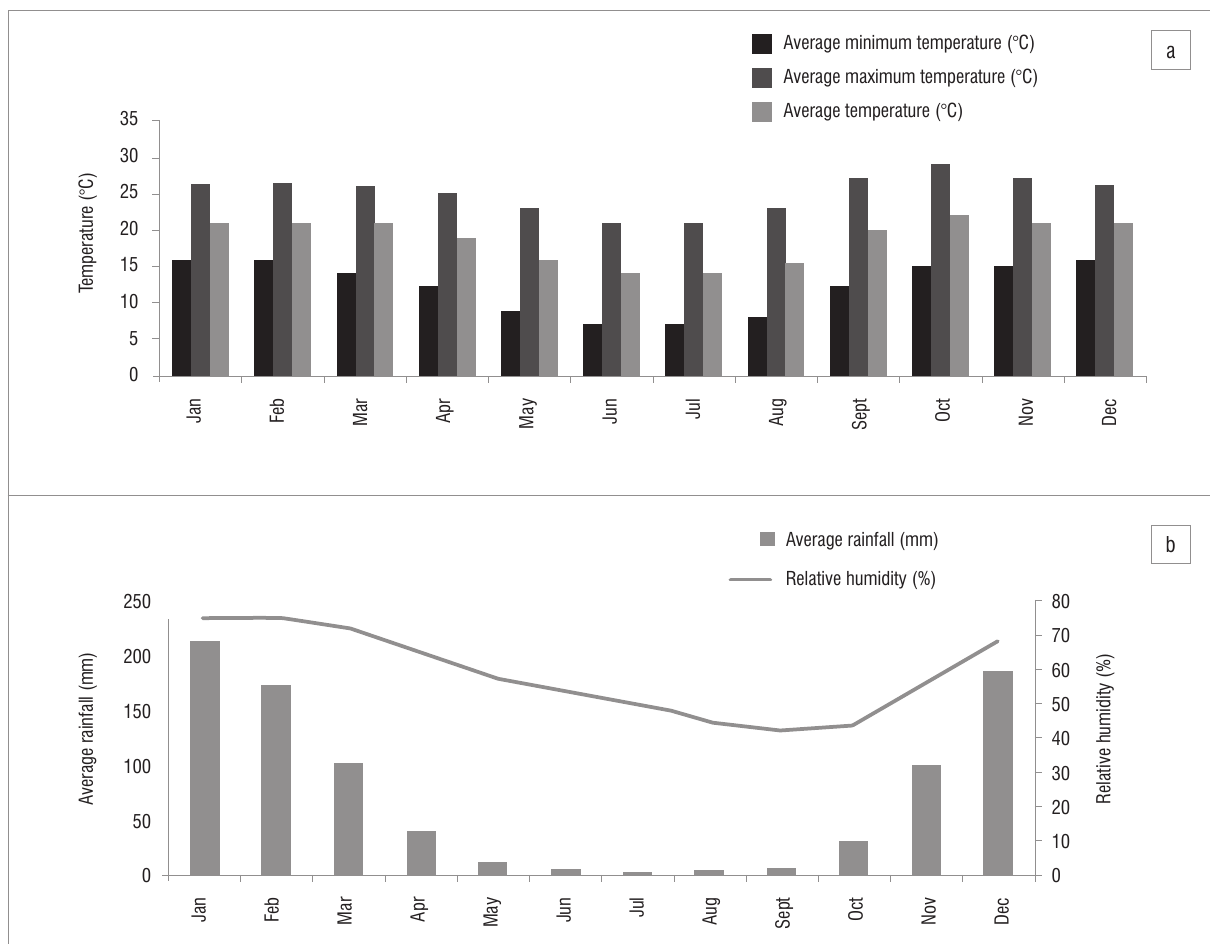
Figure 1: Average (a) temperatures and (b) humidity and rainfall for Harare,